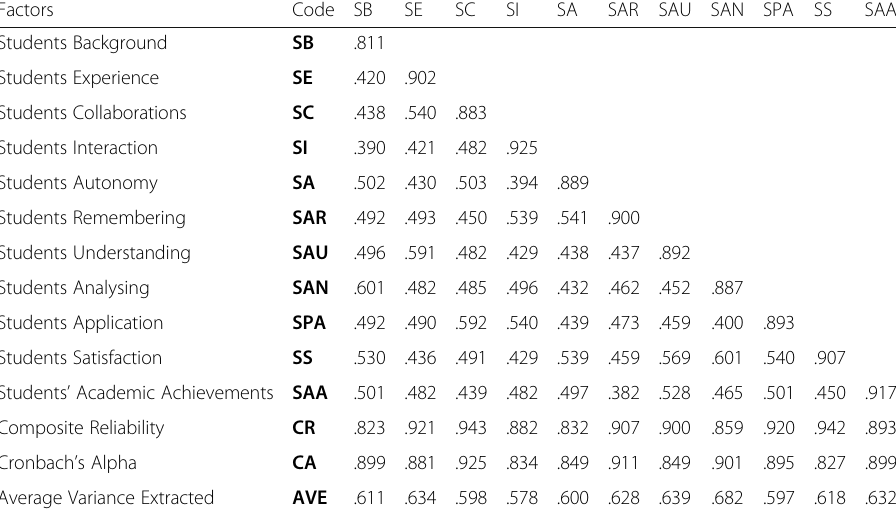
Table 2 Validity and Reliability for the Model